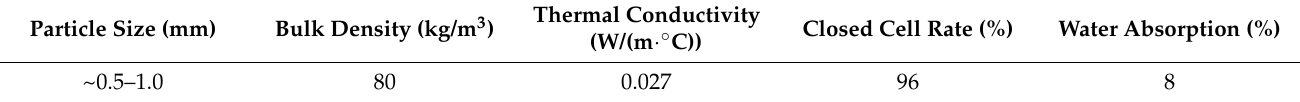
Table 2. Physical properties of glazed hollow beads.